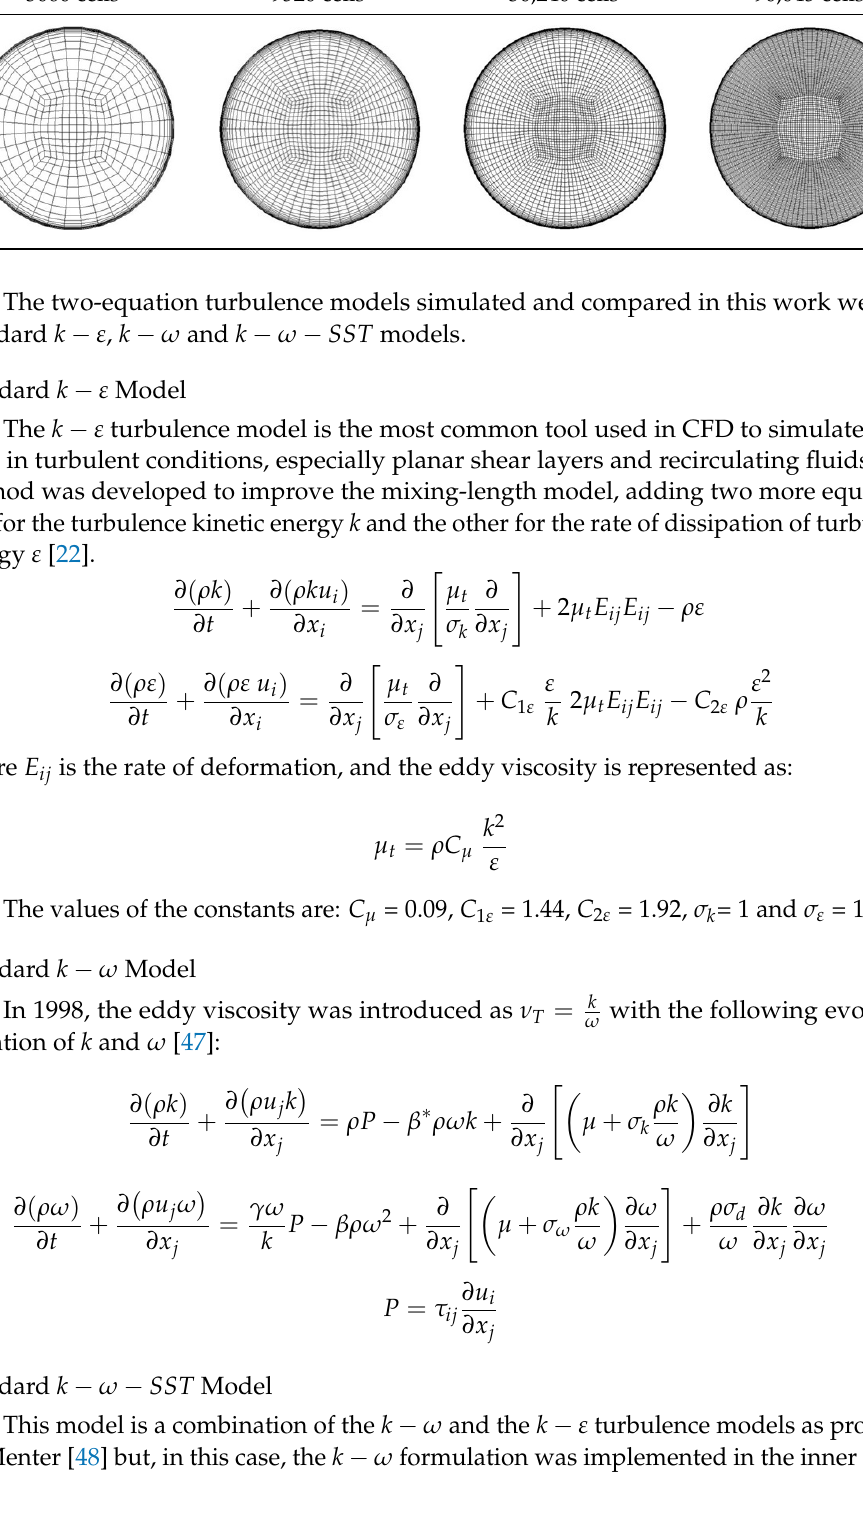
Table 1. Comparative table of 3D Multiblock/Hexahedral grid method. Coarse Mesh Medium